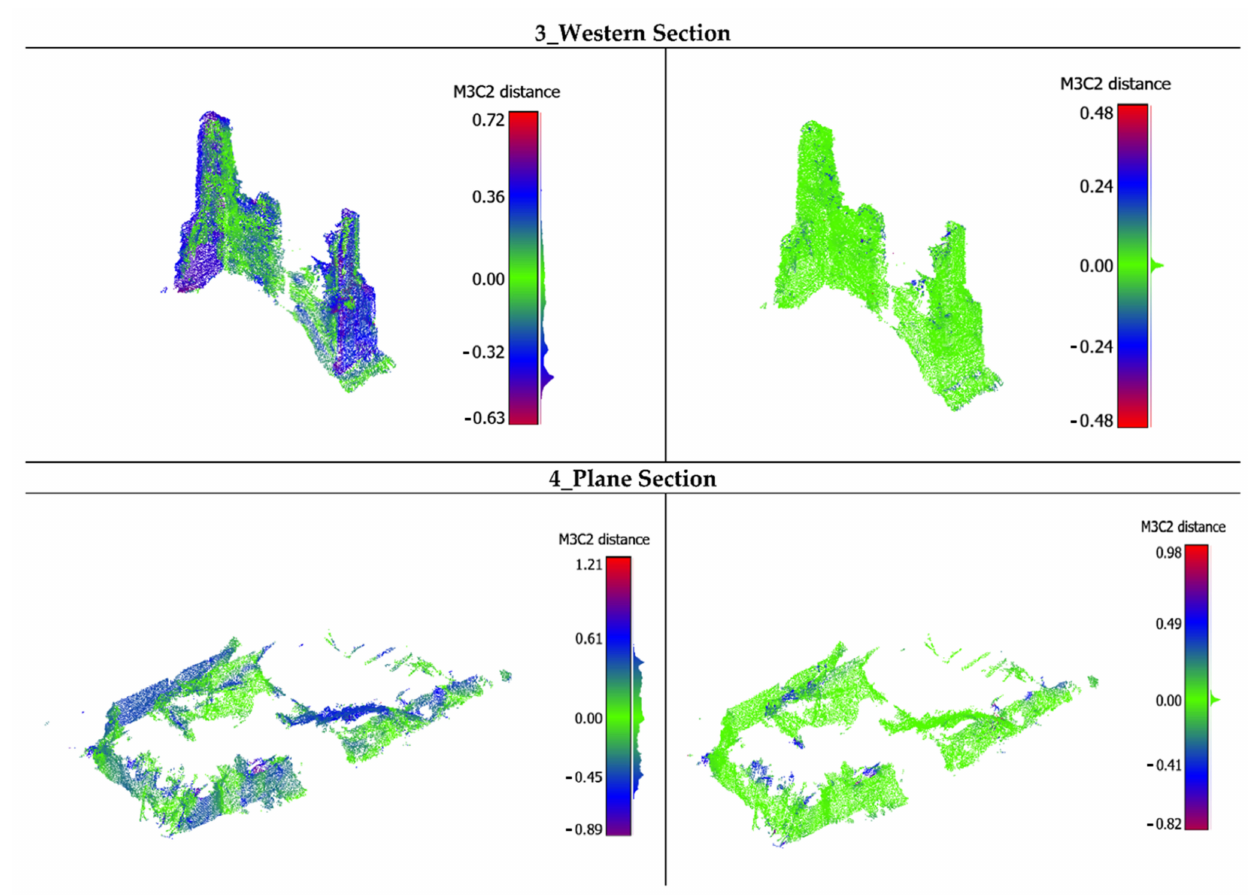
Figure 18. M3C2 analysis of the building along different sections with direct geo-referencing and after ICP. Faro Focus 3D X130 TLS is used as reference and DJI Zenmuse L2 as compared